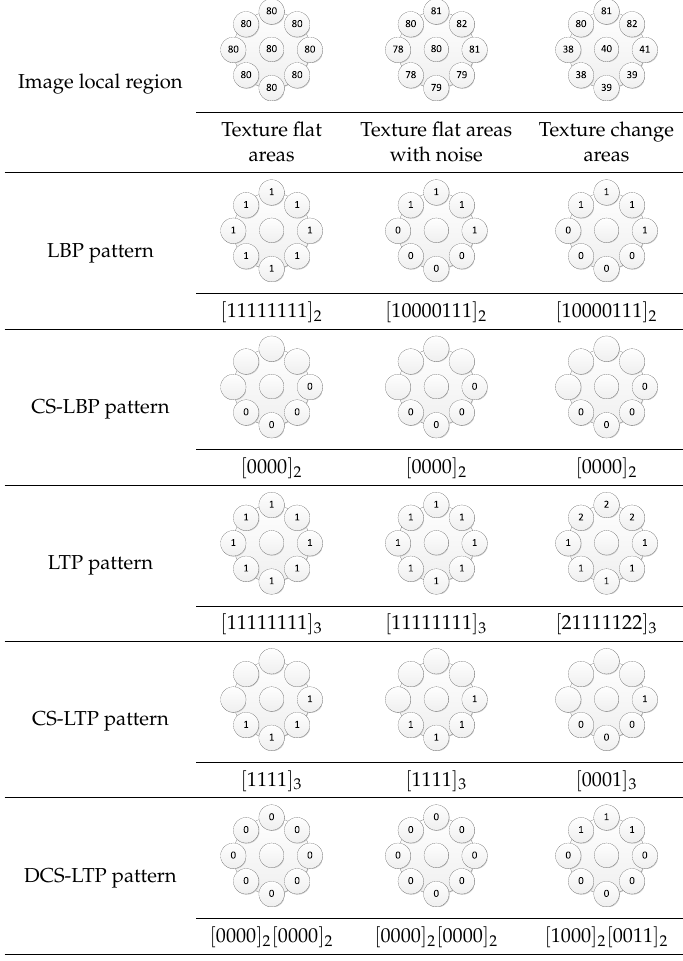
Table 1. Examples of five coding rules ( T =